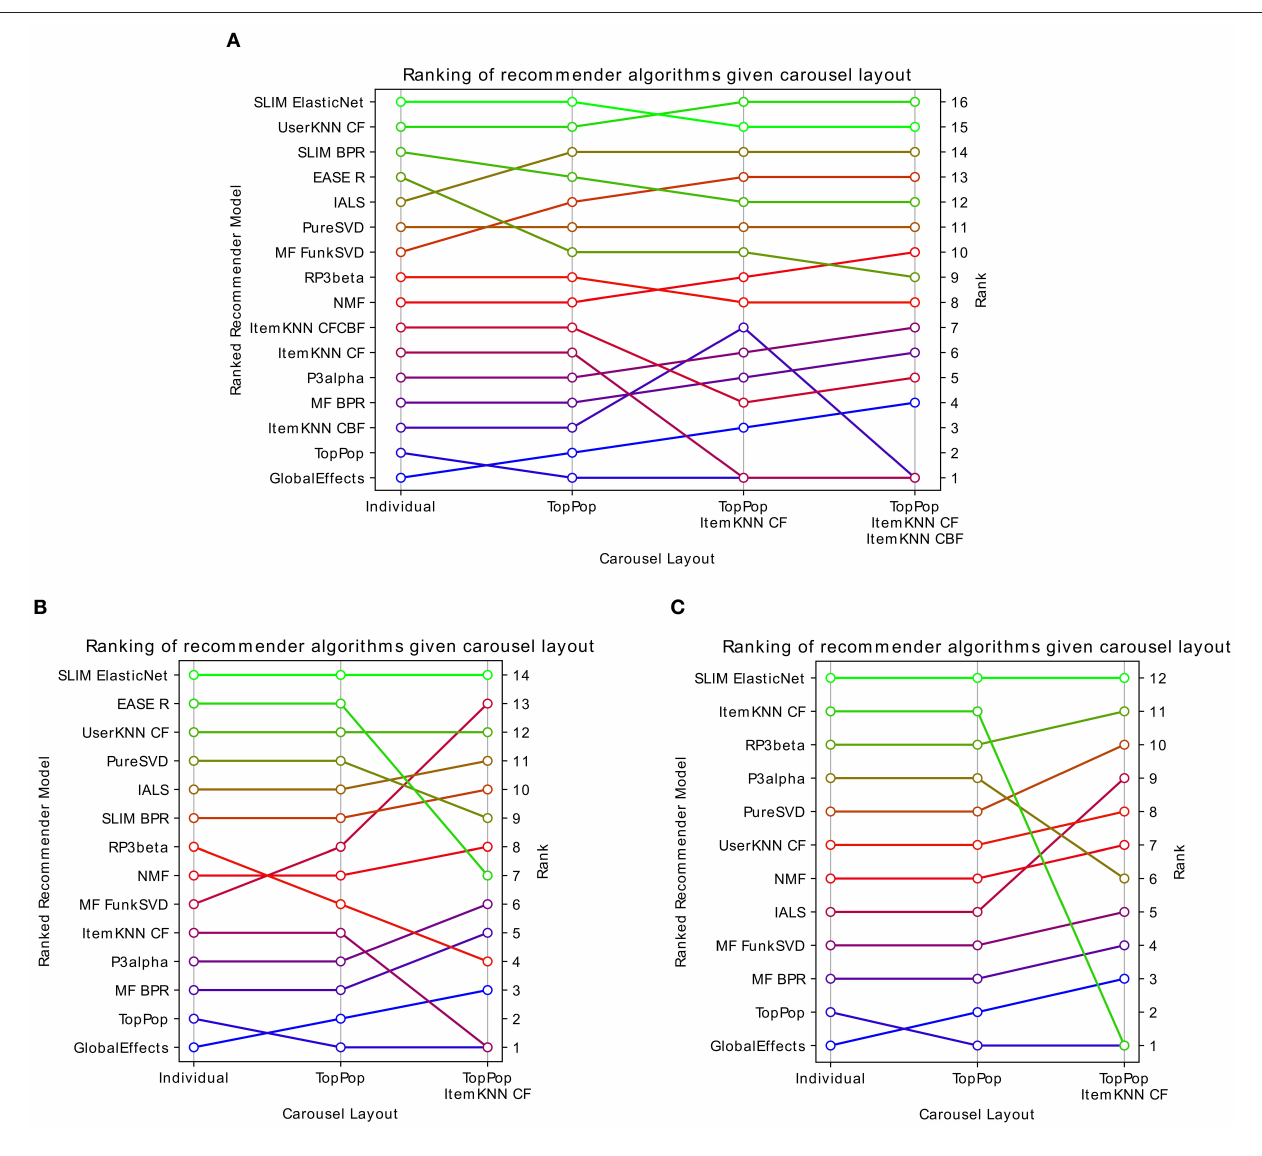
FIGURE 7 | Visualization of how the ranking of several recommendation models changes when they are evaluated independently or as the last recommendation list in a carousel interface of increasing complexity. (A) Movielens 20M, (B) Netflix Prize, and (C) ContentWise Impressions. Highest ranked models are the best performing according to NDCG at